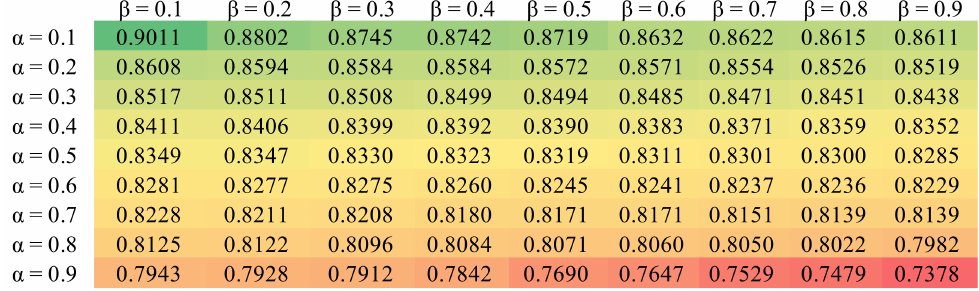
Figure 3. Heatmap of AUC results of adjustment parameters.